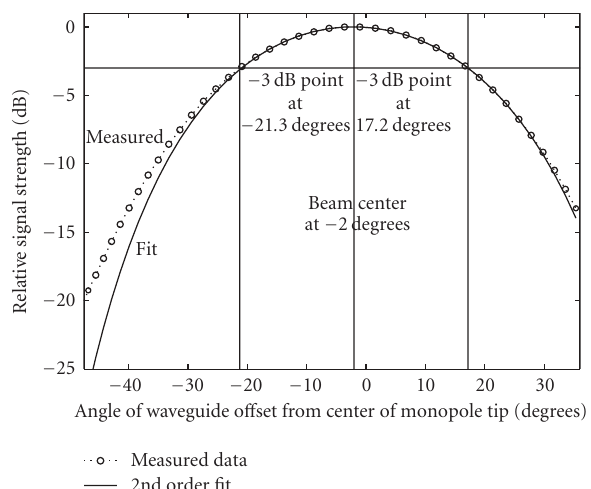
Figure 7: Vertical beam pattern for the 3.4cm length monopole antenna at 1596 MHz in a 90% glycerin: water bath. A 15-point 2nd order polynomial was used to estimate the beam center location and is also shown along with the points 3dB below the peak value.